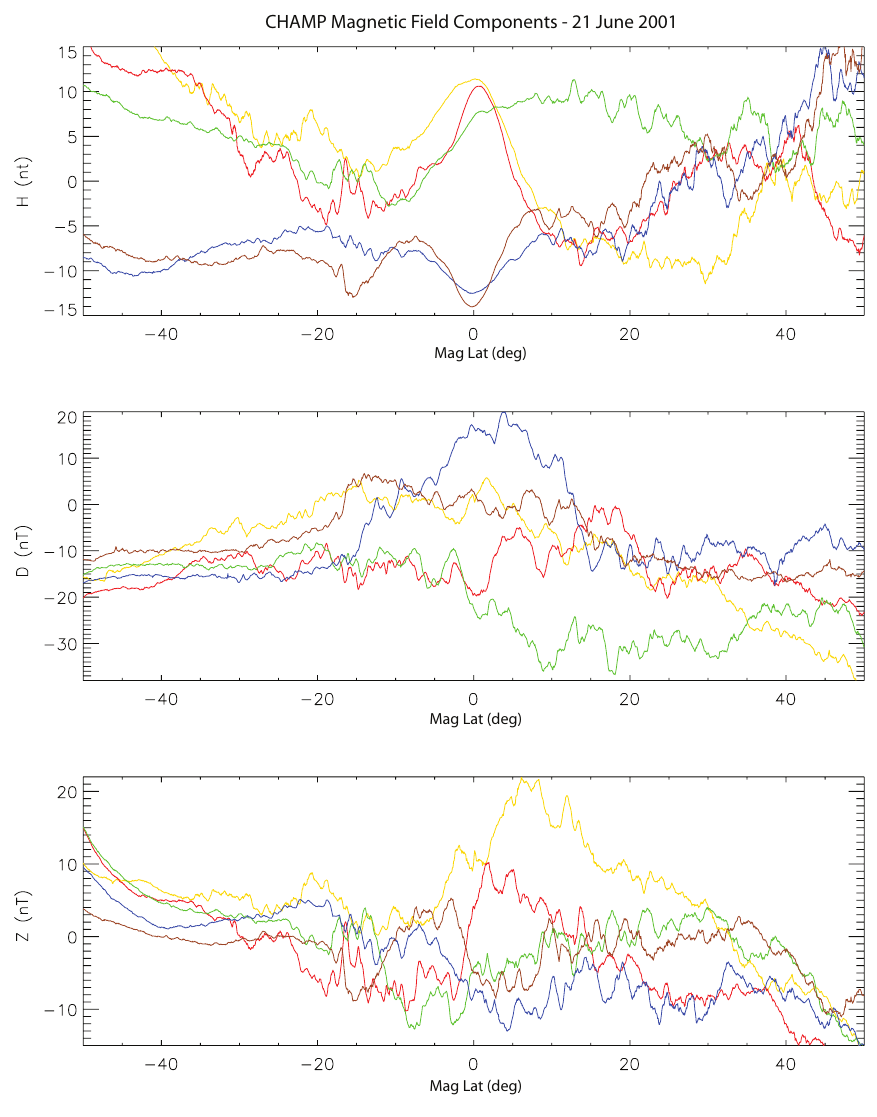
Fig. 2. Variation of the H , D , and Z magnetic field components versus corrected magnetic latitude. The same colour code as in Fig. 1 is